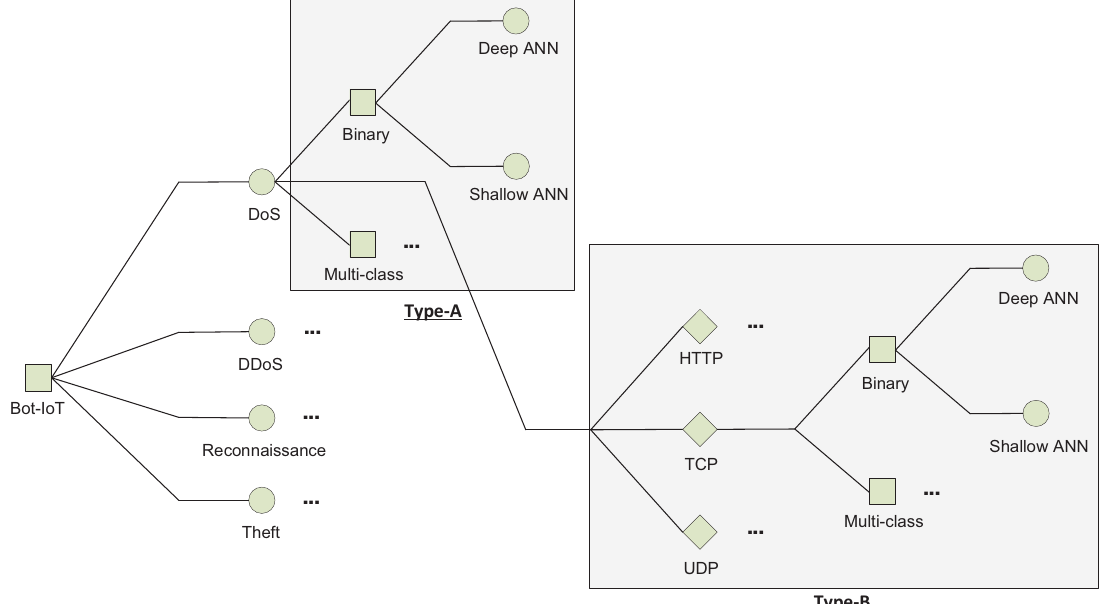
Figure 2. Example of Type-A and Type-B sets’ generation and machine learning models’